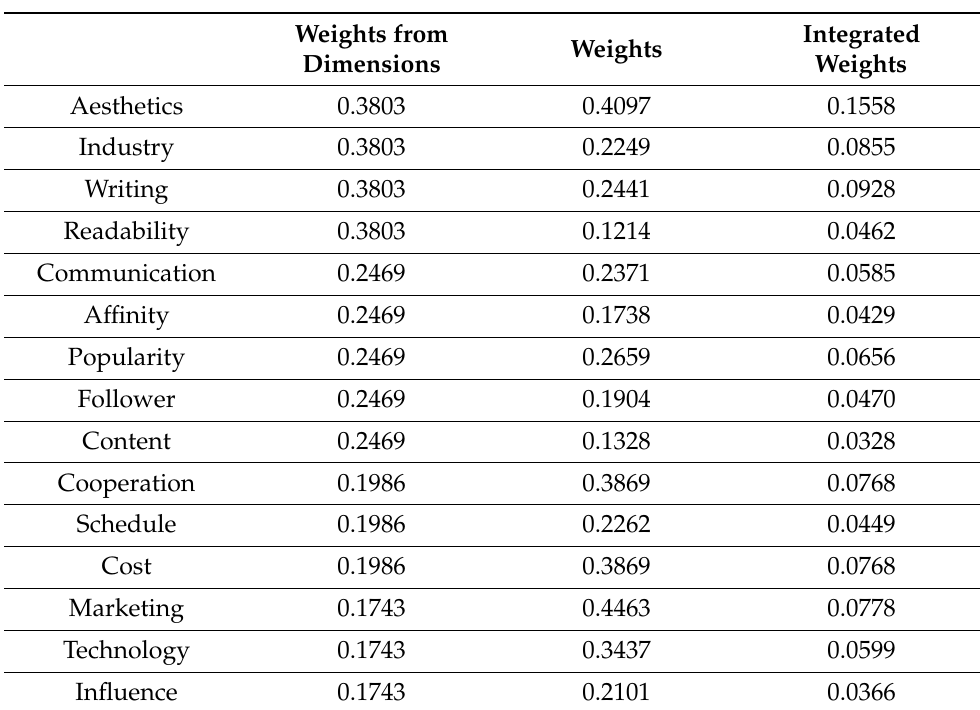
Table 5. The integrated weights of